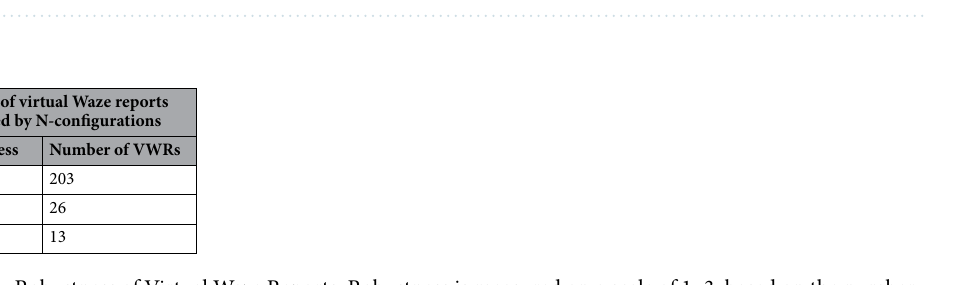
Table 2. Spatial (S) and temporal (T) clustering values derived from N points. Spatial and temporal clustering values derived for N points.